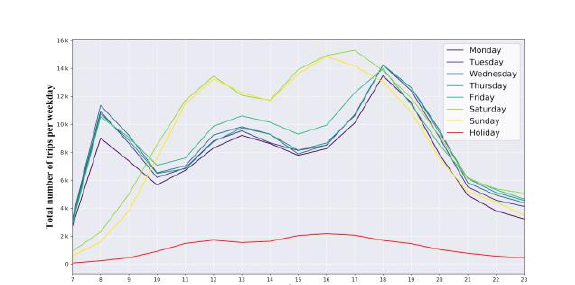
Figure 8. Hourly trips count during the week based on day and user typology (occasional